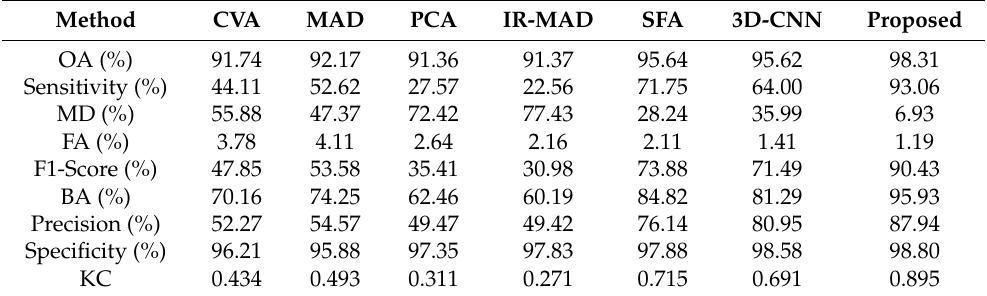
Table 2. The accuracy of different change detection methods for the PolSAR-San Francisco